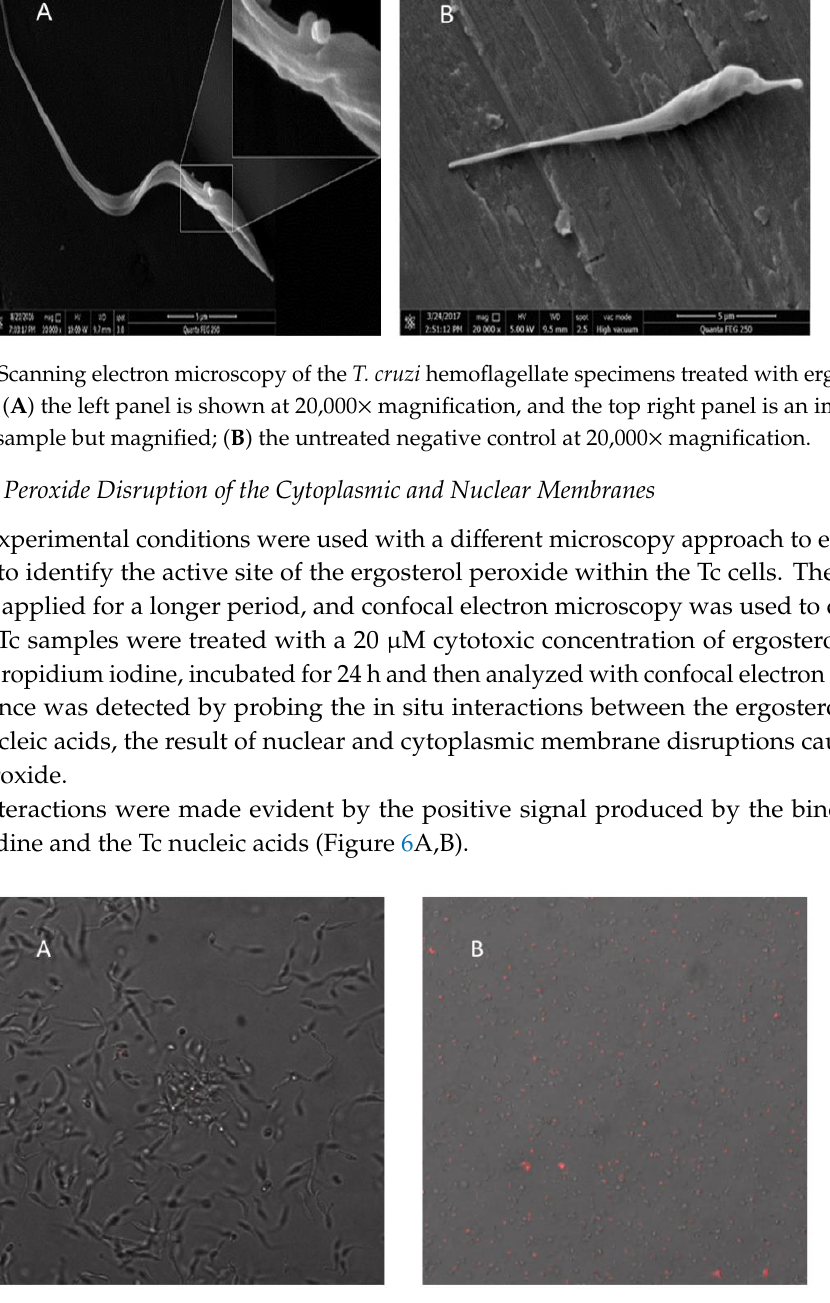
Figure 7. Transmission electronic microscopy images of a T. cruzi sample treated with 20 µM of ergosterol peroxide for 24 h. ( A ) treated sample, left panoramic, right amplification; ( B ) higher with arrows showing pores; ( C ) untreated sample showing (n) nucleus (m) membrane (k) kinetoplast.